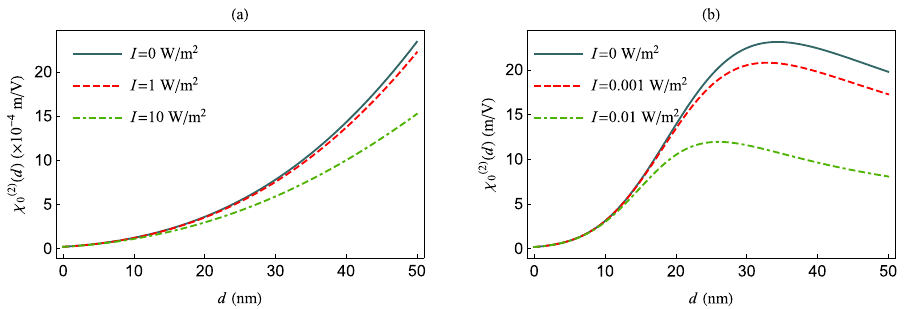
( 2 ) ( δ = 0 ) as a function of d , for δ = 0 and γ Figure 9. χ 0 but for γ d = Γ i . The QS transition dipole moment is along the z -axis ( a ) and x -axis ( b ), 0 f